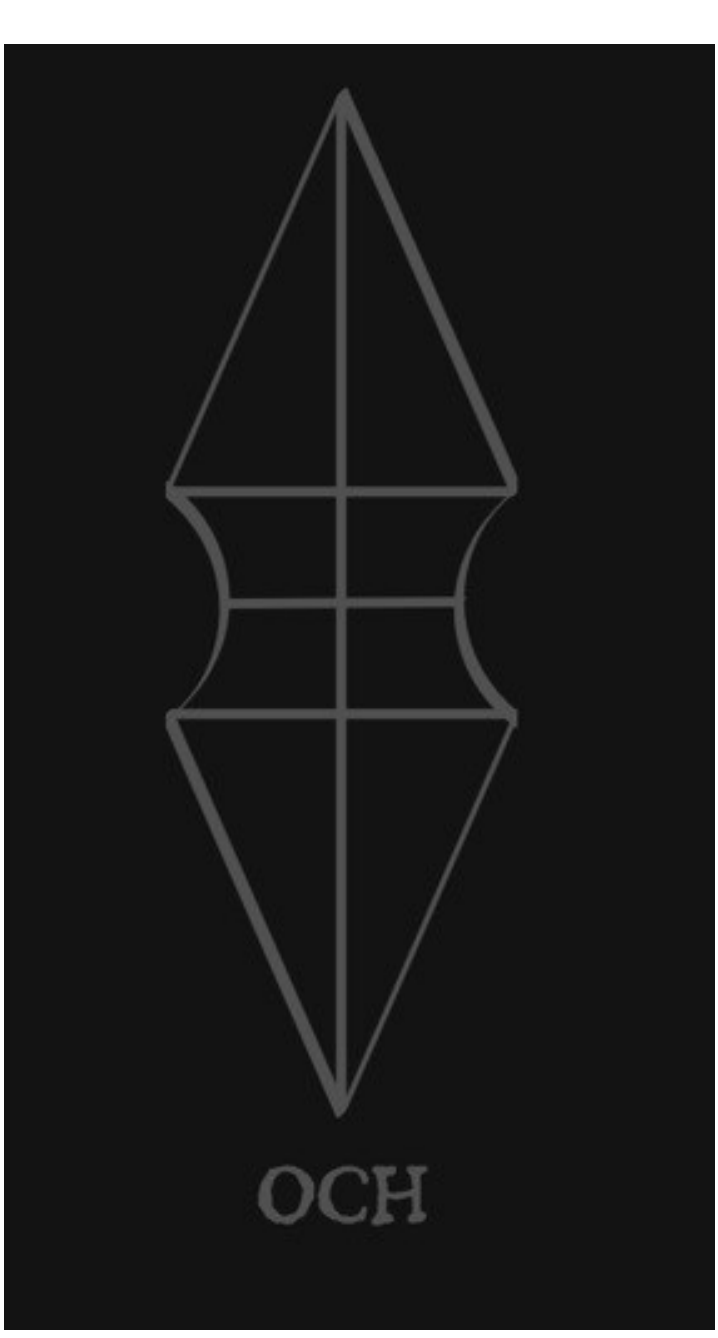
Figure 3 The shape of OCH, 72 © Frater